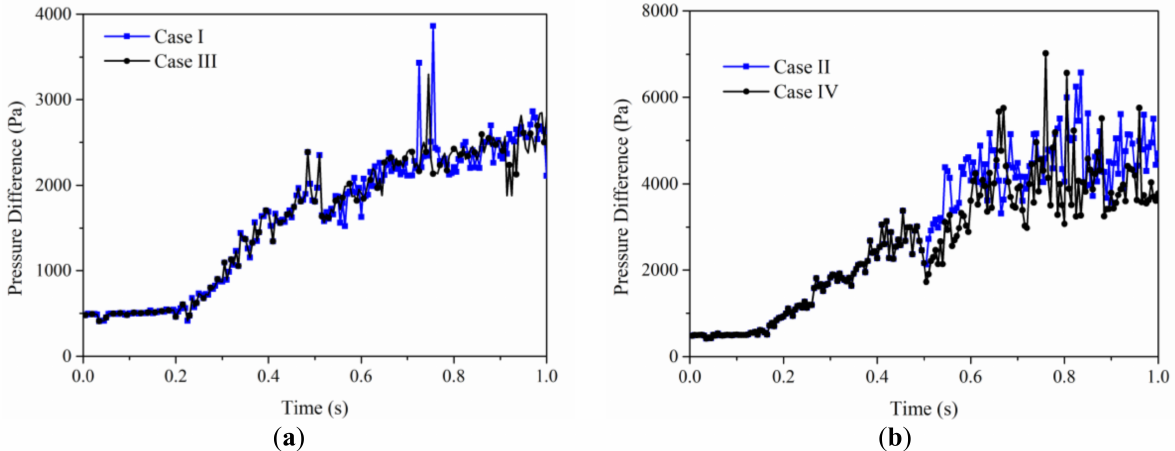
Figure 18. Comparison of inlet–outlet pressure difference with time between continuous injection and slug injection: ( a ) small particles, ( b ) large particles.